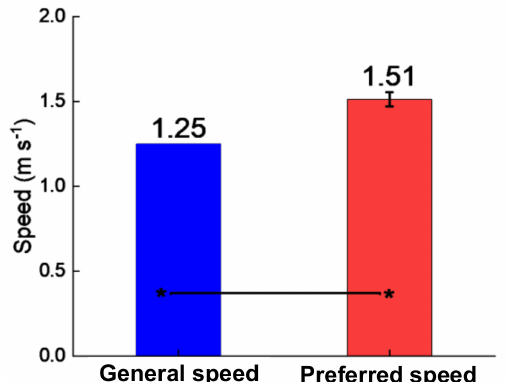
Figure 6. Mean (bars) and standard deviation (whiskers) of preferred walking speed under the normal and preferred condition (general speed and preferred speed); lines with asterisks denote statistically significant differences (Wilcoxon test, α = 0.05).